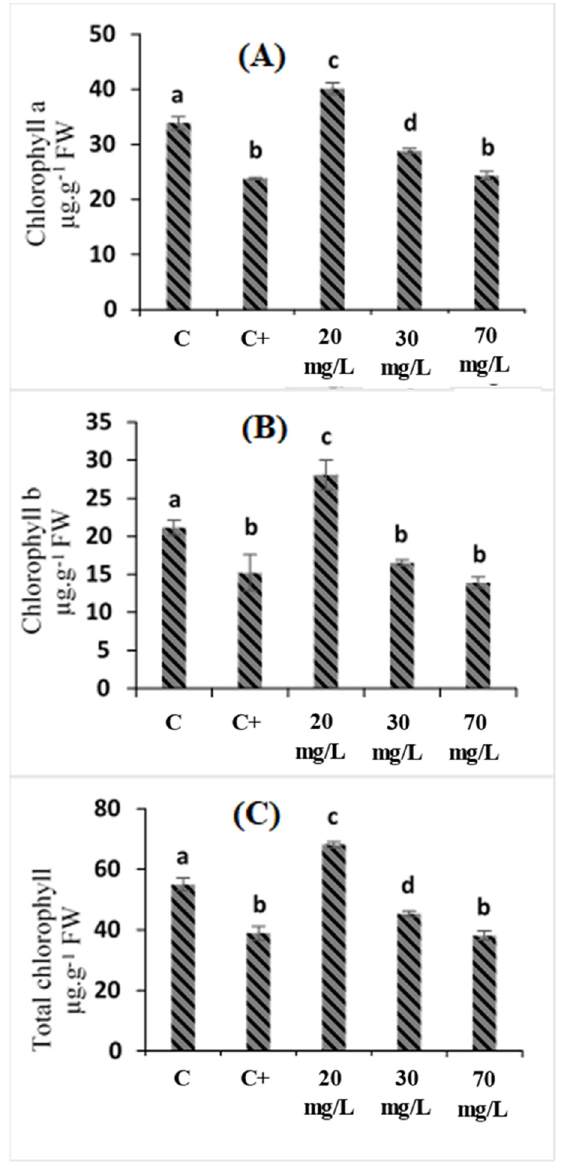
Figure 1. The effects of Crataegus oxyacantha extract on pigment chlorophyll content in tomato plants under salt stress: ( A ) chlorophyll a; ( B ) chlorophyll b; ( C ) total chlorophyll. Different letters indicate significant differences between conditions ( p < 0.05) within conditions according to Tukey’s multiple range test.